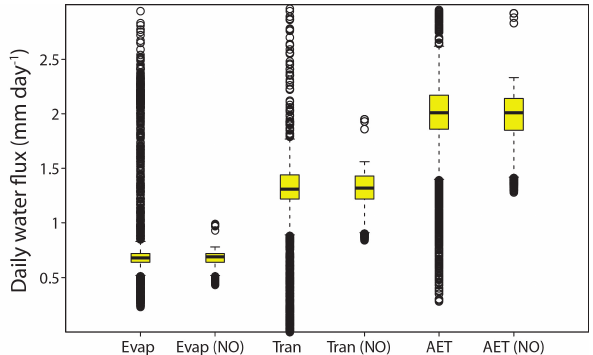
Fig. 4. Comparison of simulated monthly average daily evaporation (evap), transpiration (Tran), and actual evapotranspiration (AET) in July, 1994 between the two simulations with and without (indicated by “NO”) consideration of water